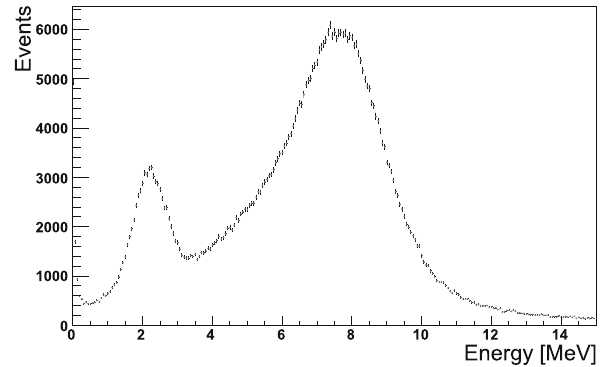
Fig. 12 Reconstructed delayed events energy distribution from the simulated IBD events